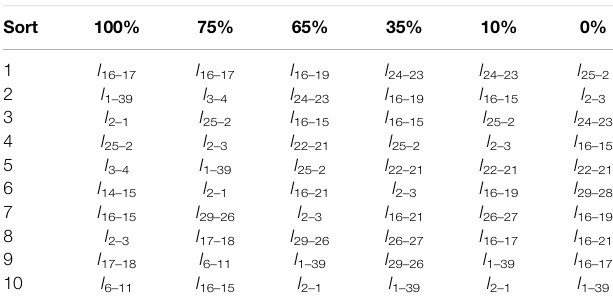
TABLE 4 | Sorting of key lines in multiple time